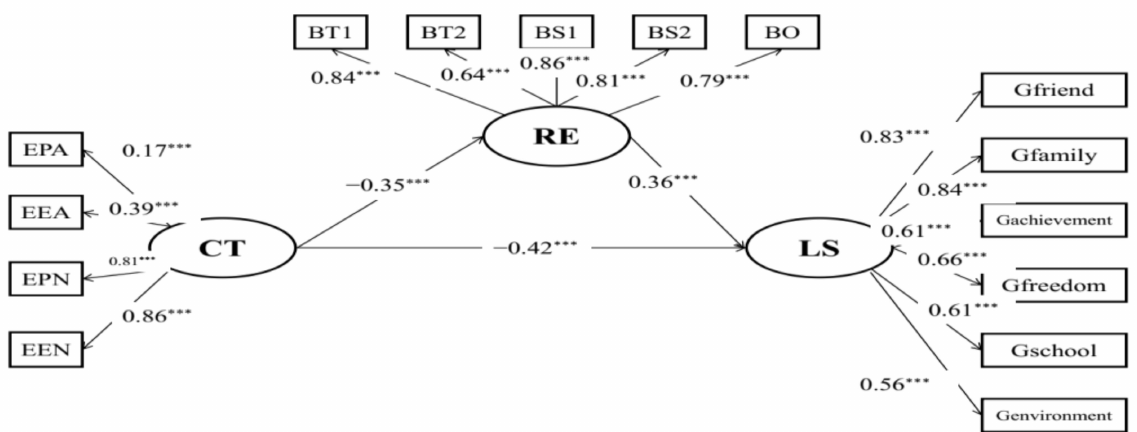
Figure 1. Mediation model of child maltreatment, life satisfaction, and resilience. EPA: physical abuse; EEA: emotional abuse; EPN: physical neglect; EEN: emotional neglect; BT1: tenacity 1; BT2: tenacity 2; BS1: strength 1; BS2: strength 2; BO: optimism; CT: childhood maltreatment; LS: life satisfaction; RE: resilience; *** p < 0.001.